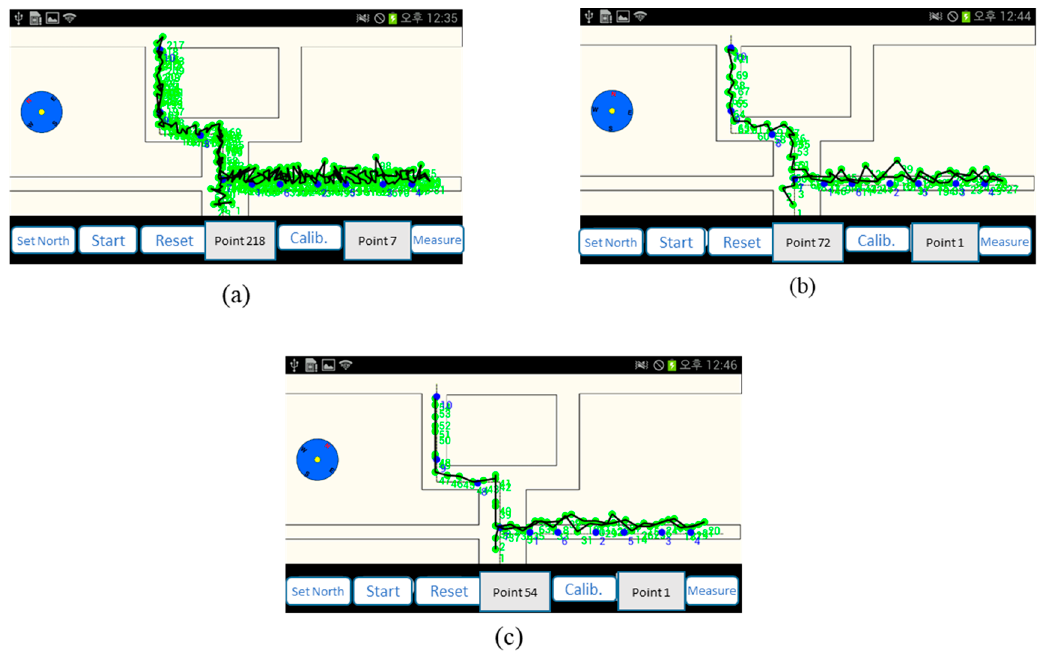
Figure 8. Traces for k value: ( a ) k = 1, ( b ) k = 1.5, ( c ) k =